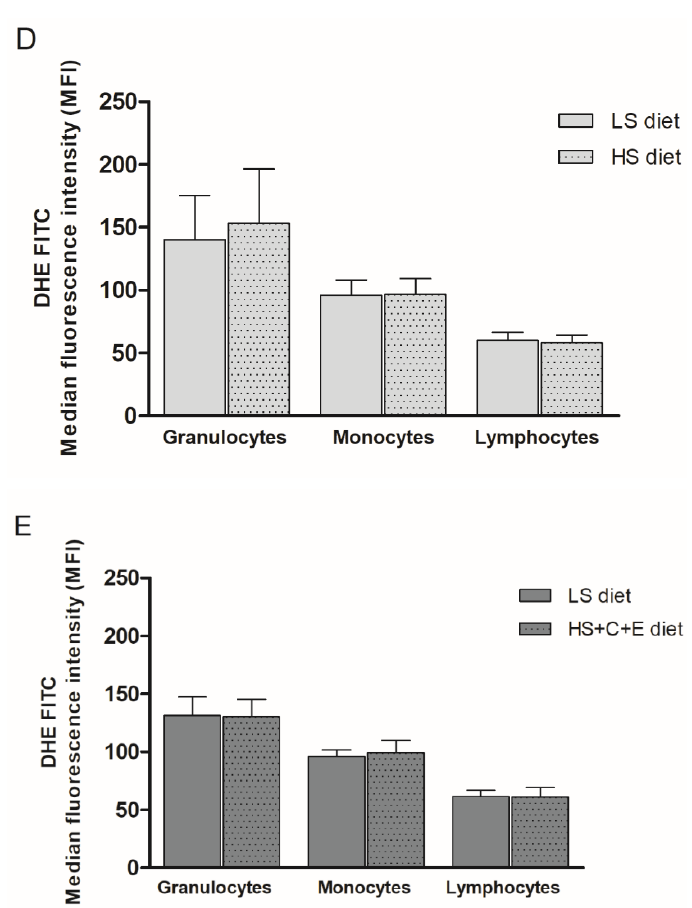
Figure 3. The effect of the 7-day high-salt (HS) diet without (HS group) and with vitamin C and E (HS + C + E group) supplementation on superoxide (DHE) formation in peripheral blood leukocytes (PBL)—granulocytes, monocytes, and lymphocytes in young healthy individuals. ( A ) shows gating strategy for excluding doublets and defining leukocytes subpopulations based on the size (FSC) and complexity (SSC), ( B ) shows histograms expressing the level of oxidative stress in individual leukocyte populations, and ( C ) shows the comparison of the expression of oxidative stress in monocytes at study enrollment (gray), after 7 days of low-salt (blue) and after 7 days of high-salt diets (red). ( D , E ) shows the median fluorescence intensity of DHE FITC on peripheral blood leukocytes in HS and HS + C + E groups. Data are presented as mean ± SD.